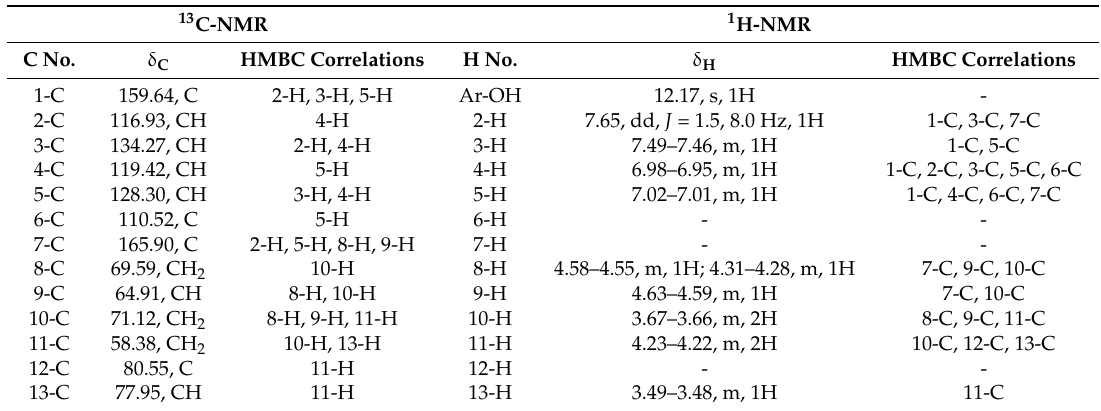
Figure 4. The main HMBC of compound 6j . Table 5. HMBC data of compound 6j